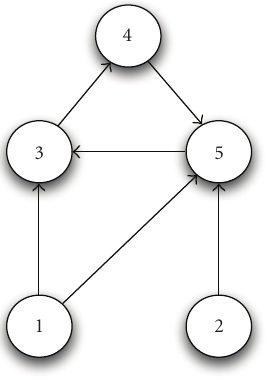
Figure 1: A hypothetical trophic web with five species. Species 1 and 2 are “grazers” at the bottom level, which acquire nutrients directly from the environment and provide nutrients to species 3 and 5. Species 3, 4, and 5 form a dependent cycle, with 3 and 5 at the second level of the web and 4 at the final